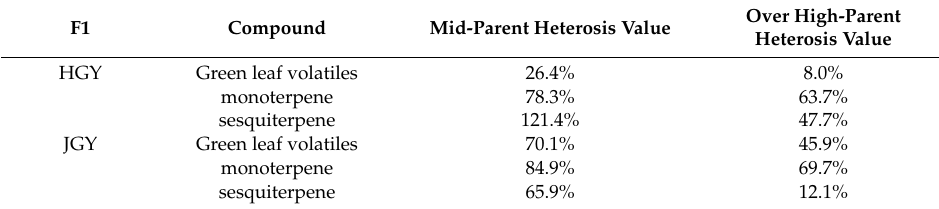
Table 2. Heterosis of volatiles content of hybrid combination (HD × TGY) in tea.